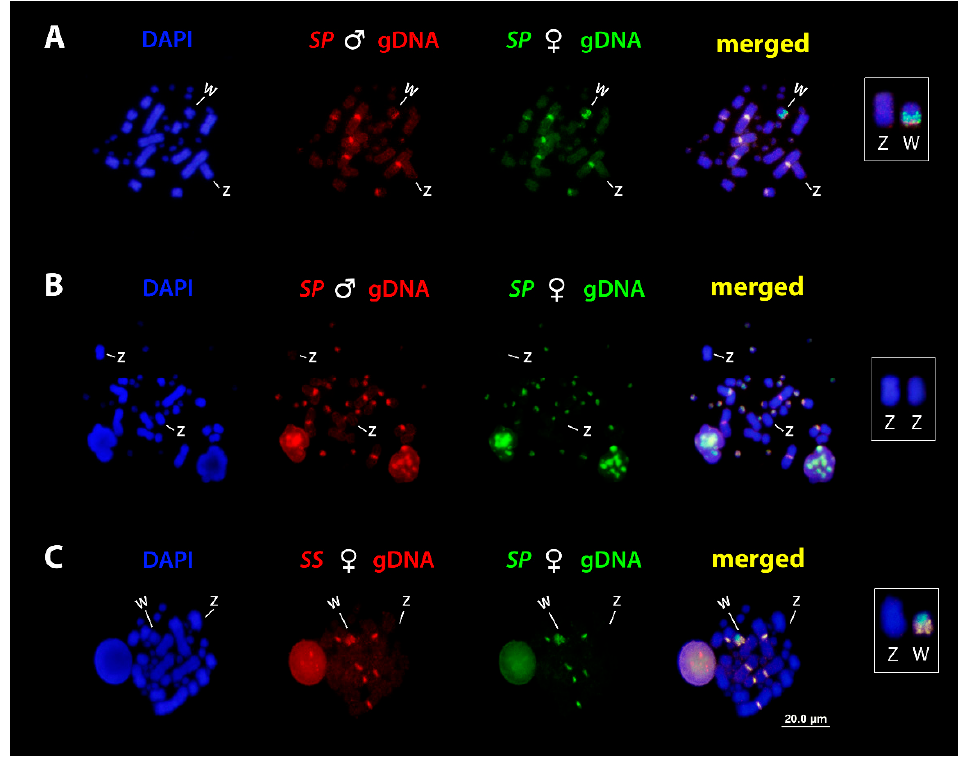
Figure 3. Mitotic chromosome spreads of S. pullatus after comparative genomic hybridization (CGH) procedures and cross-Species comparison. Male and female-derived genomic probes from S. pullatus mapped against female ( A ) and male ( B ) chromosomes of S. pullatus . ( C ) Female-derived genomic probes from S. pullatus ( SP ) and S. sulphureus ( SS ) mapped against female chromosomes of S. pullatus . The common genomic regions are identified as yellow. Please note the shared regions of the W chromosomes in both species and absence of signals on Z chromosome. Z and W sex chromosomes are boxed .